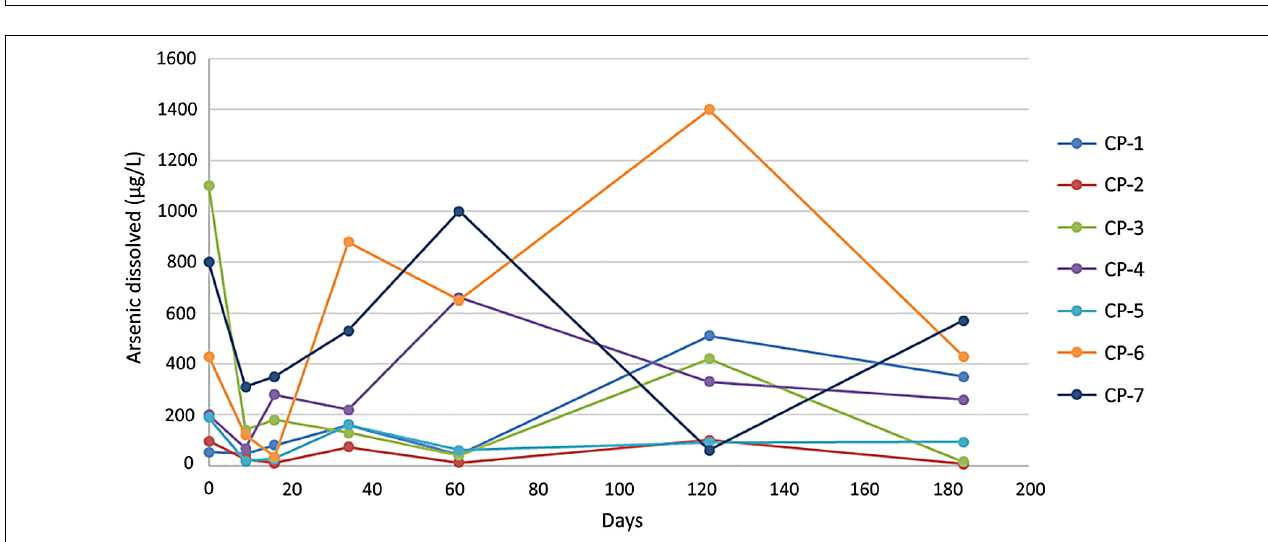
FIGURE 5 | Dissolved arsenic concentration ( µ gL − 1 ) in groundwater at the different injection wells during remediation. The values shown for the individual wells correspond to the average of three measurements with a standard error < 5%.